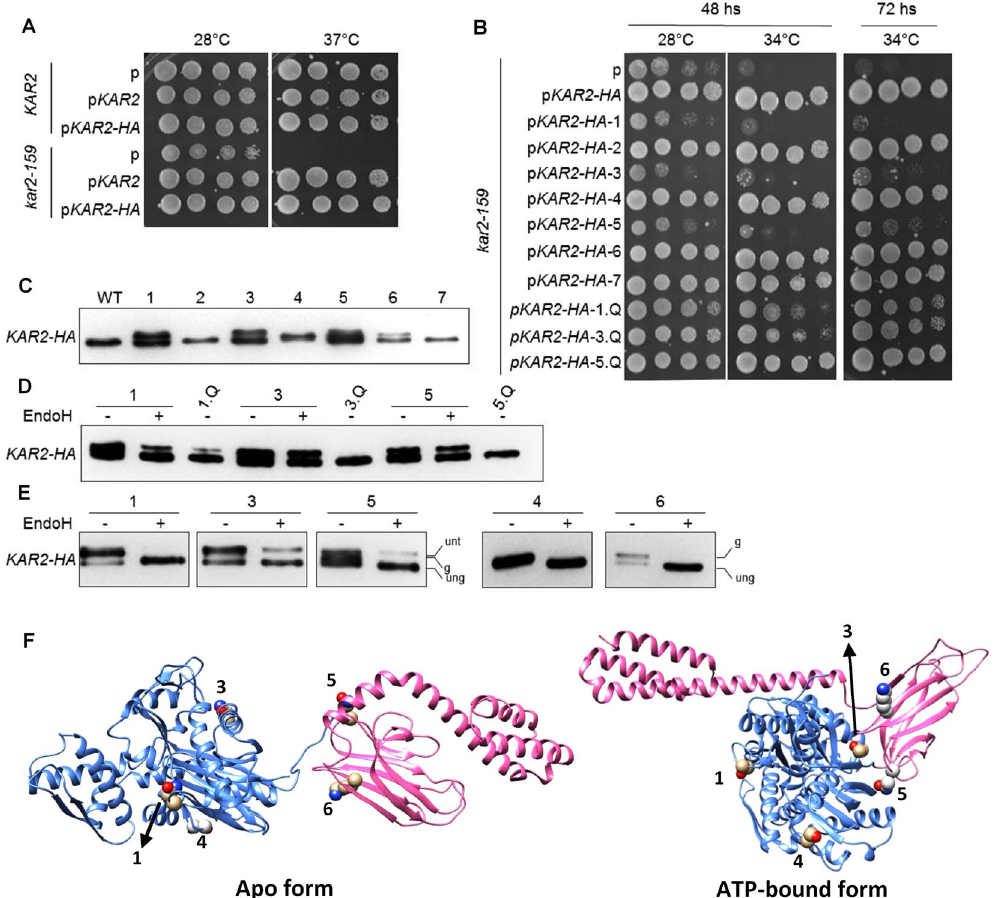
Figure 5. Introducing N -glycosylation sites in yeast Kar2 severely impairs its function. The wild-type yeast strain KAR2 and the temperature sensitive mutant kar2-159 were transformed with an empty vector (p), or vectors for the expression of Kar2, Kar2-HA, variant Kar2-HA introducing sequons 1 through 7 (see text for details), or Kar2-HA sequon-revertants 1.Q, 3.Q, or 5.Q, as indicated. In sequon revertants, the introduced sequons encoding Asn were replaced by the codon encoding Gln. ( A ) Liquid cultures of transformed KAR2 and kar2-159 strains or ( B ) kar2-159 strains transformed with KAR2-HA glycosylation variants were grown overnight, serially diluted, spotted onto SC-URA plates and grown at the indicated temperatures and times. ( C ) anti-HA western blot from kar2-159 transformed with wild type KAR2-HA or glycosylation variants 1–7. ( D ) and ( E ) Protein extracts with or without EndoH treatment, separated through SDS-PAGE, and blotted with anti-HA antibody. (ung) is unglycosylated, (g) is glycosylated, (unt) is untranslocated. ( F ) Cartoon structures of Kar2 showing the location of introduced glycosylation sequons that were glycosylated. N-terminal and C-terminal domains are depicted in blue and pink ribbons,